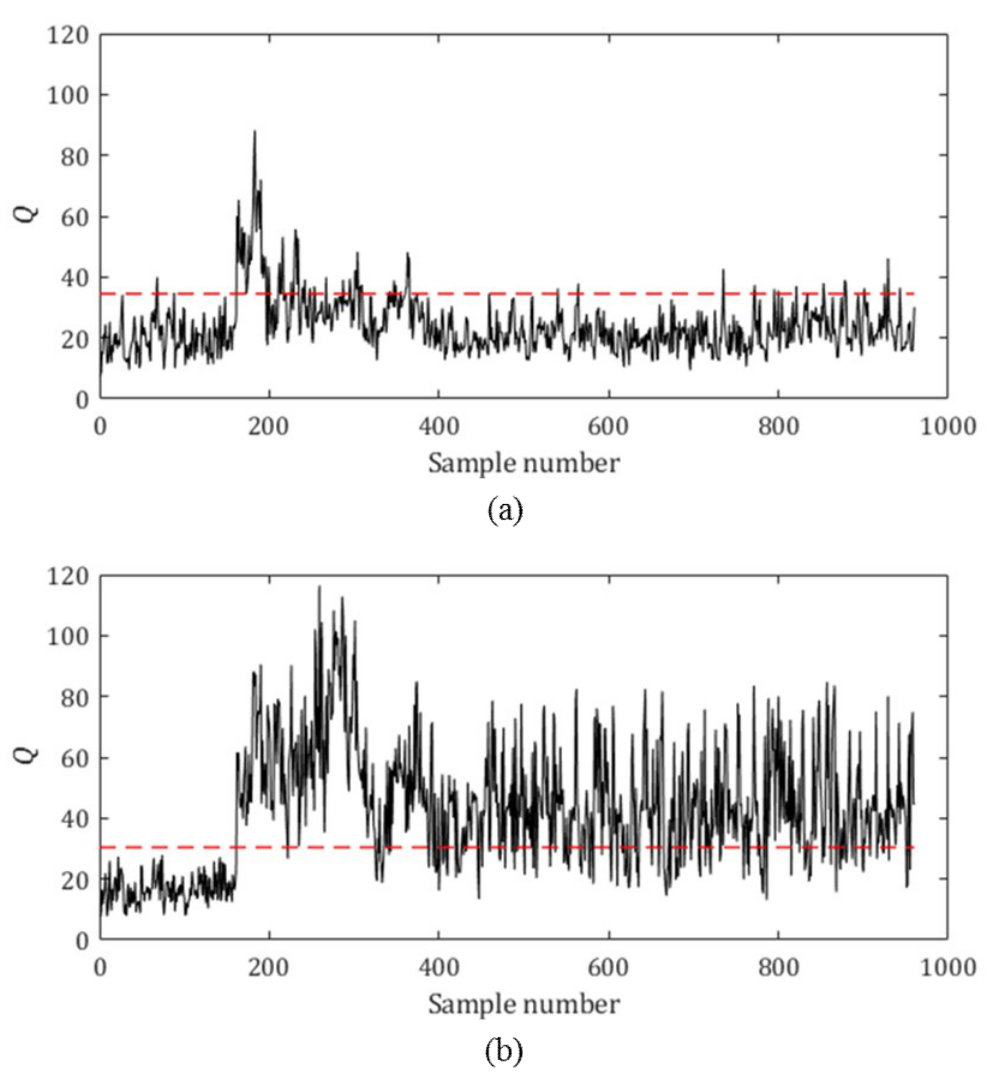
Figure 5. Process monitoring results in the residual space for Fault 5: ( a ) linear PCA; ( b ) p-NLPCA.